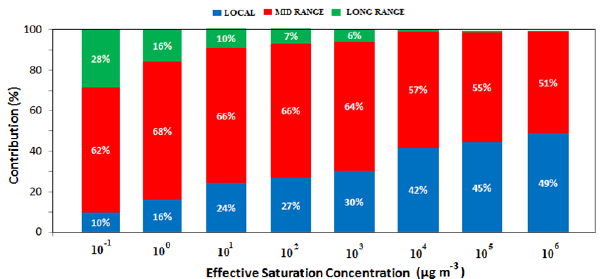
Fig. 5. Simulated source area contributions to organics (organic aerosol plus gas–phase organic mass) in Paris as a function of their volatility. Compounds with effective saturation concentrations above 10µgm − 3 are mainly in the gas phase, while the rest are par- titioned between the gas and particulate